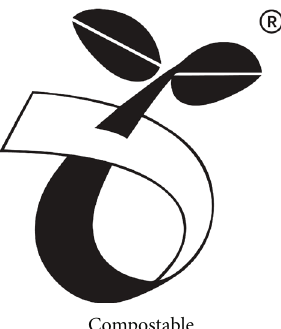
Figure 4: The international logo printed on the compostable products certi fi ed according to EN 13432/14995 standards, licensed by DIN CERTCO (®registered trademark of European Bioplastics e.V.)